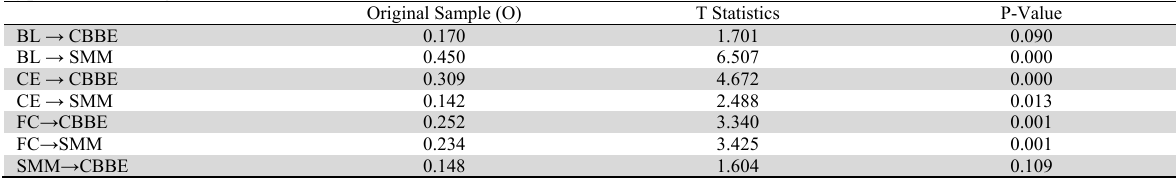
hypothesis testing (Direct